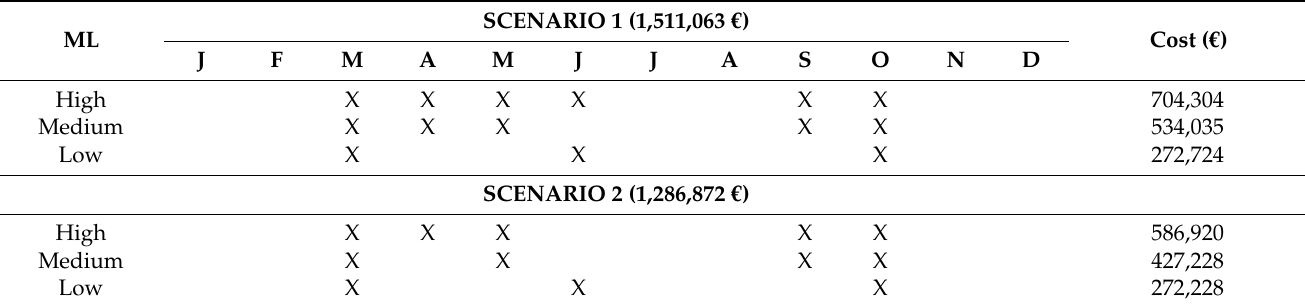
Table 8. Scenarios 1 and 2 provide cost estimation in case of a differ number of cutting operations within UOS having high and medium maintenance levels. Costs of single grass cutting operations are indicated with (*) and without (**) mowing removal for High (102,209 € **; 117,384 € *), Medium (90,092 € **; 106,807 € *) and Low (63,353 € **; 90,908 € *) maintenance levels. Last column shows the general costs for each hypothesized maintenance level.